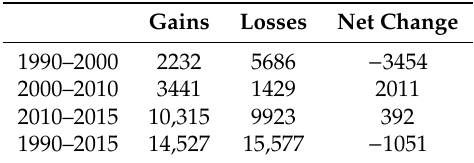
Table 3. Forest loss and gain between 1990 and 2015 (unit: km 2 ). Table 2. Forest loss and gain between 1990 and 2015 (unit: km 2 ).